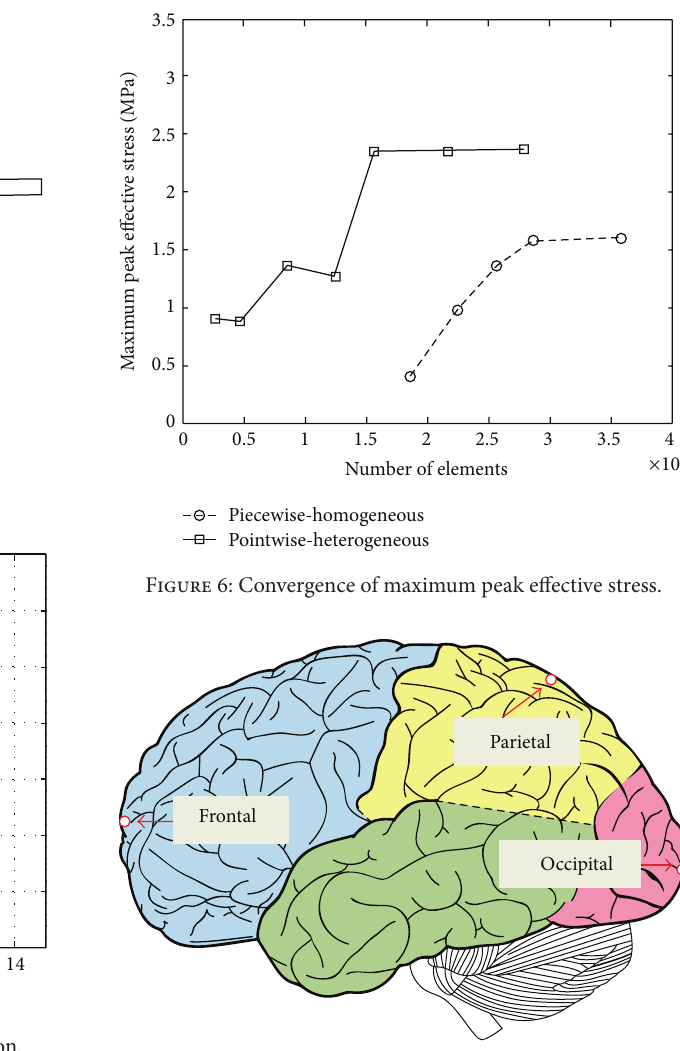
Figure 7: (a) Finite element mesh without interior segmentation; (b) locations of computed intracranial